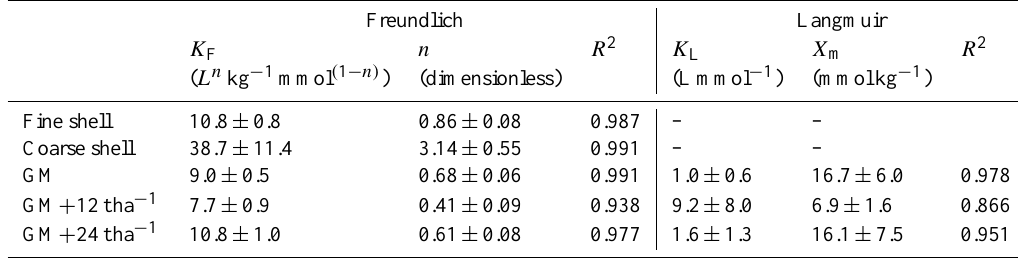
Table 3. Fitting of the adsorption results to the Freundlich and Langmuir models.